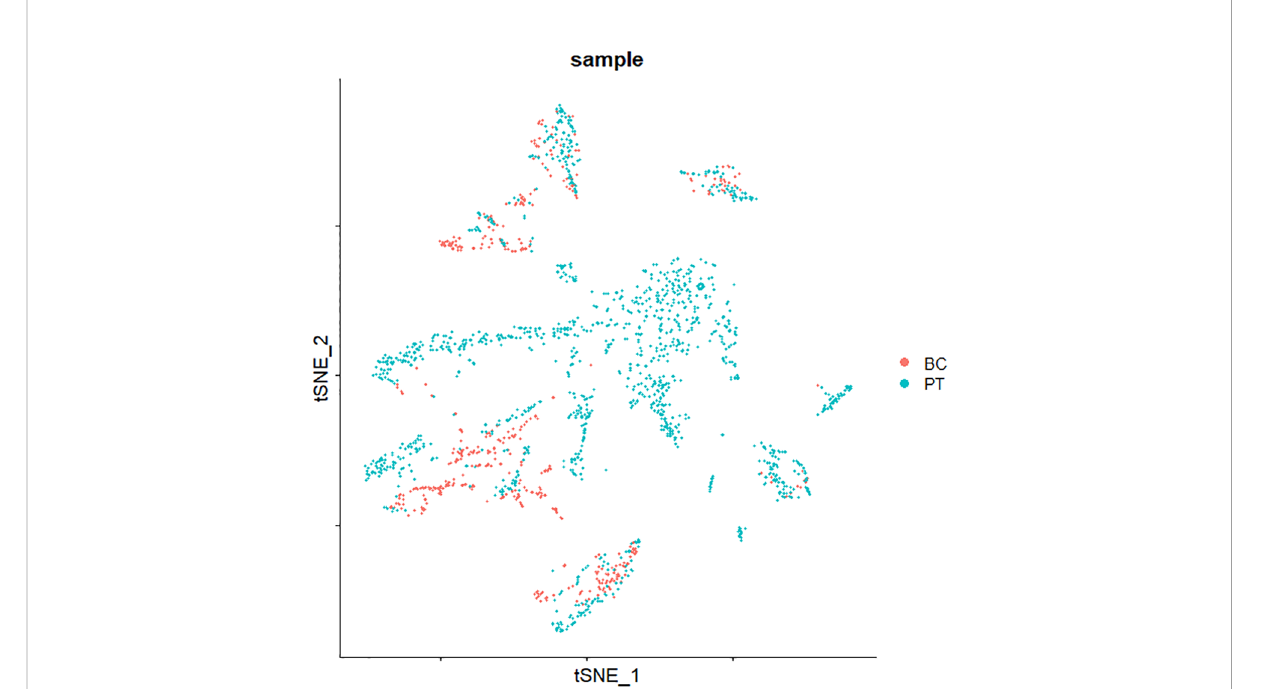
FIGURE 4 t-SNE of the integration for datasets GSE75688 and GSE118389. t-SNE, t-distributed stochastic neighbor embedding.